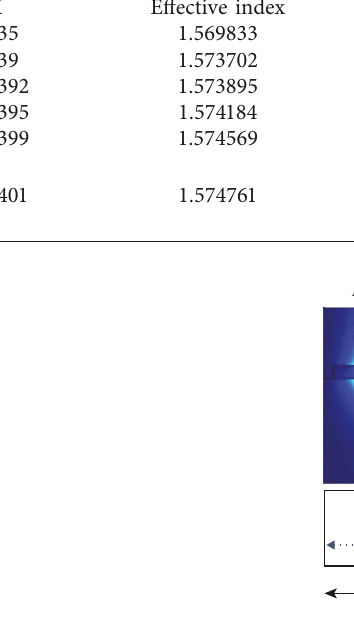
Table 6: Analysis of bulk sensitivity of rib-slot waveguide with 90nm analyte thickness. RI